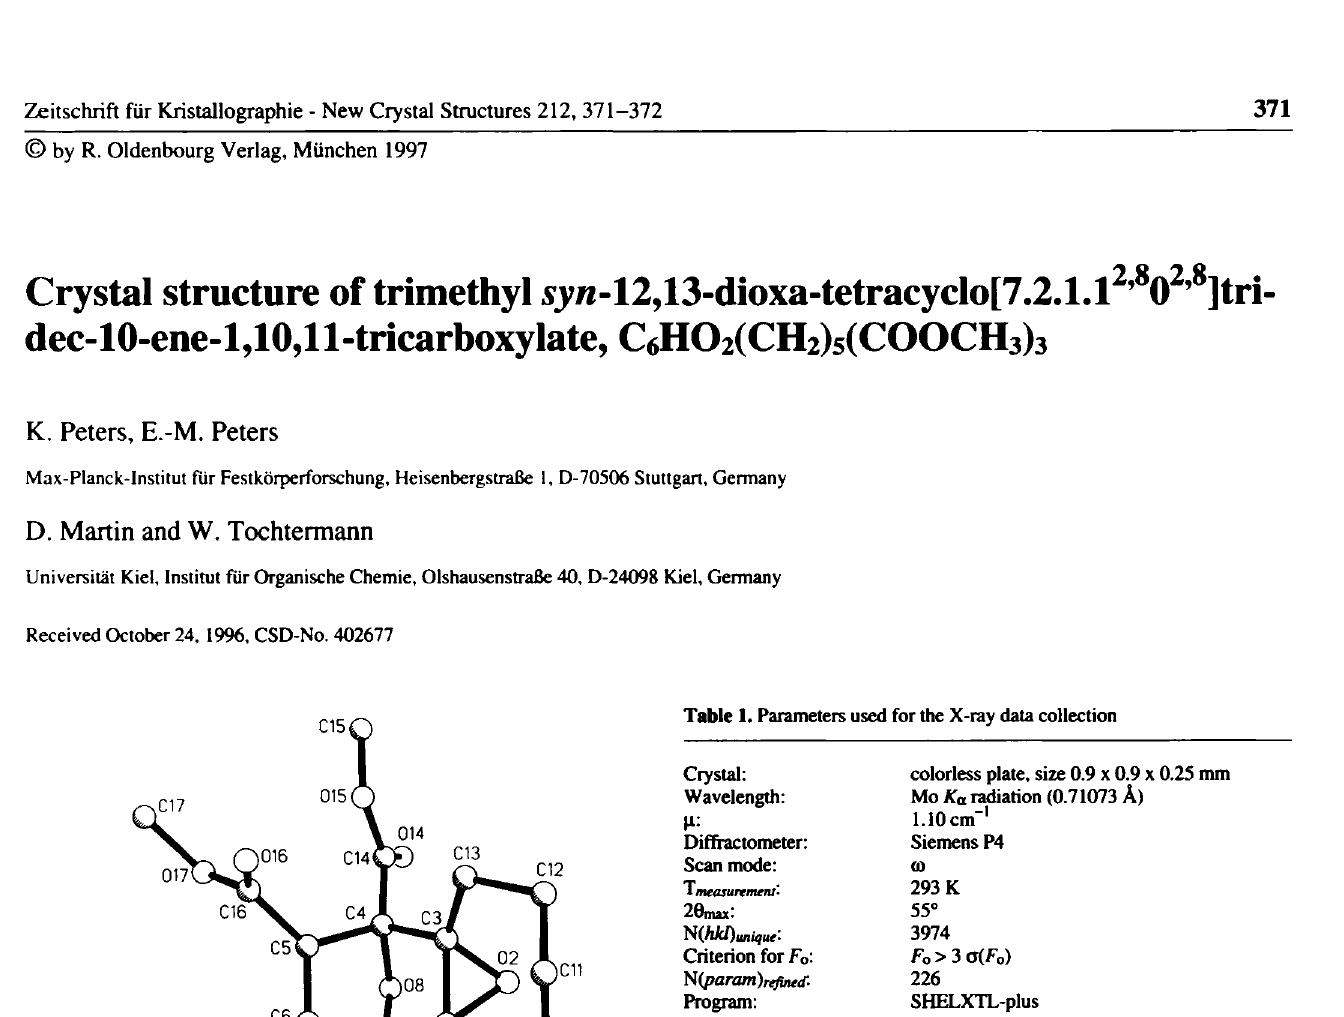
Table 2. Final atomic coordinates and displacement parameters (in Â 2